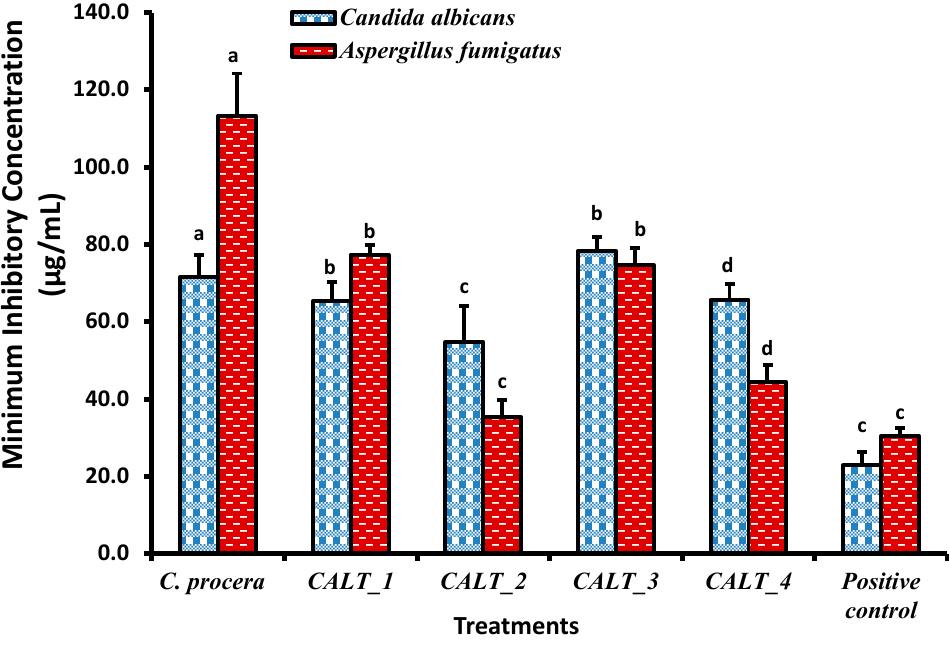
Figure 2. Minimum inhibitory concentrations ( µ g/mL) of C. procera ethanolic extract and actinobacteria isolate extracts against yeast and fungi. Values are mean ± SD; different letters (a, b, c, d) indicate significant differences.